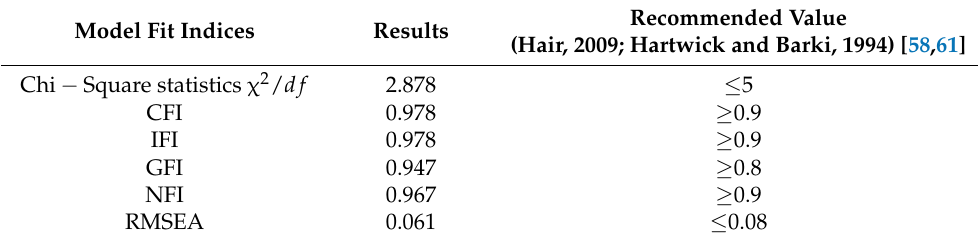
Table 3. CFA model estimates.